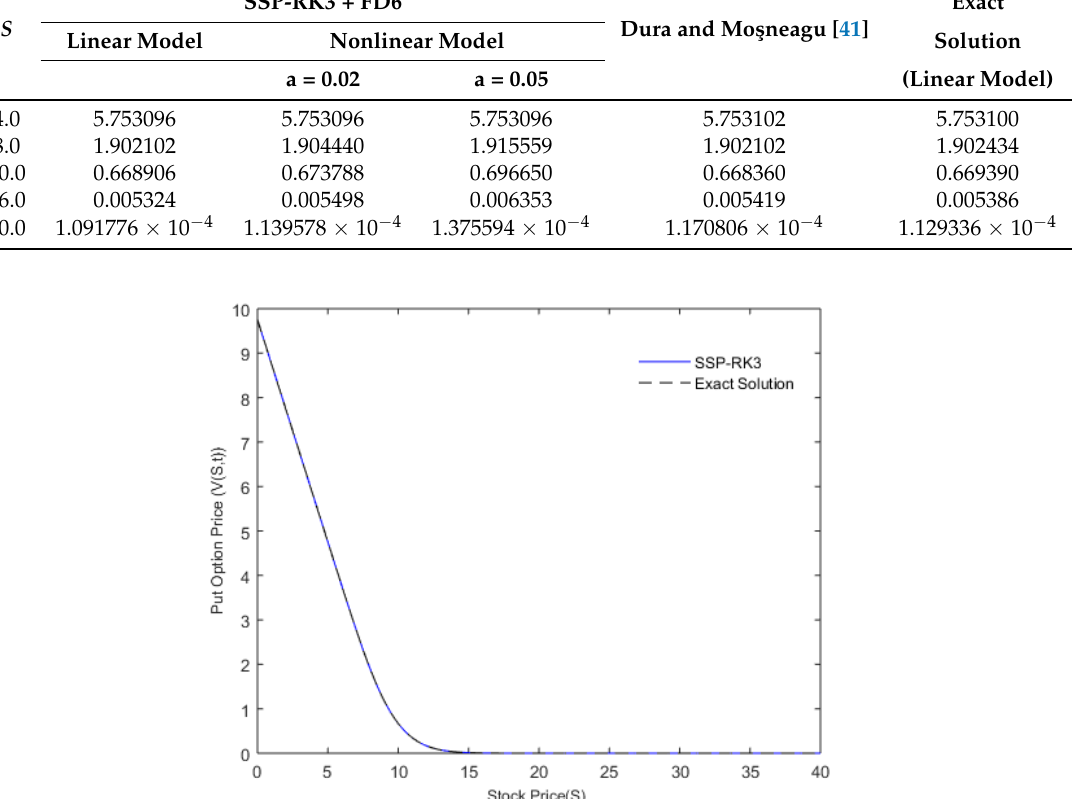
Figure 1. Prices of the linear European put option at t =